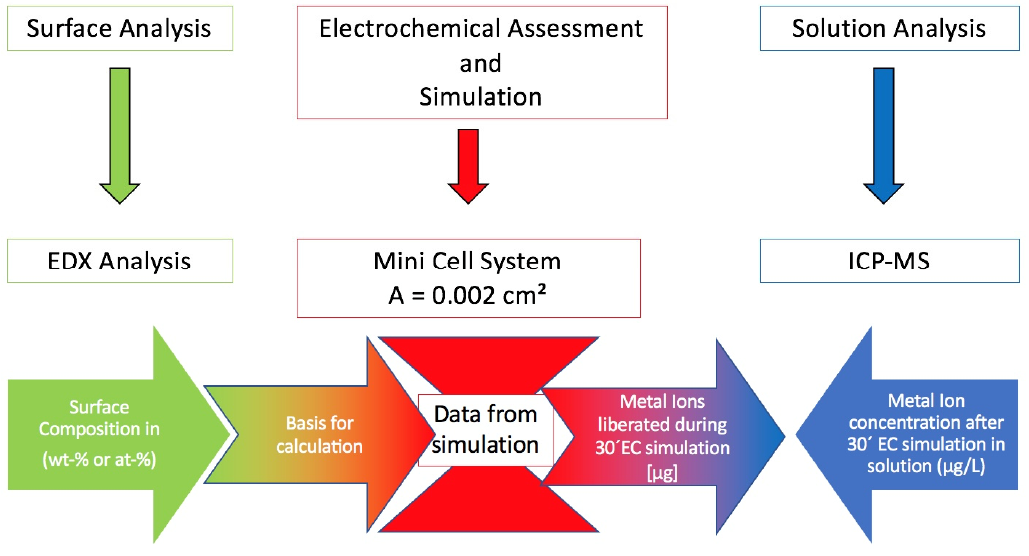
Figure 1. Summary of the setup. EDX, x-ray energy-dispersive spectroscopy; ICP-MS, inductively coupled plasma-mass spectrometer; EC, electrochemical.